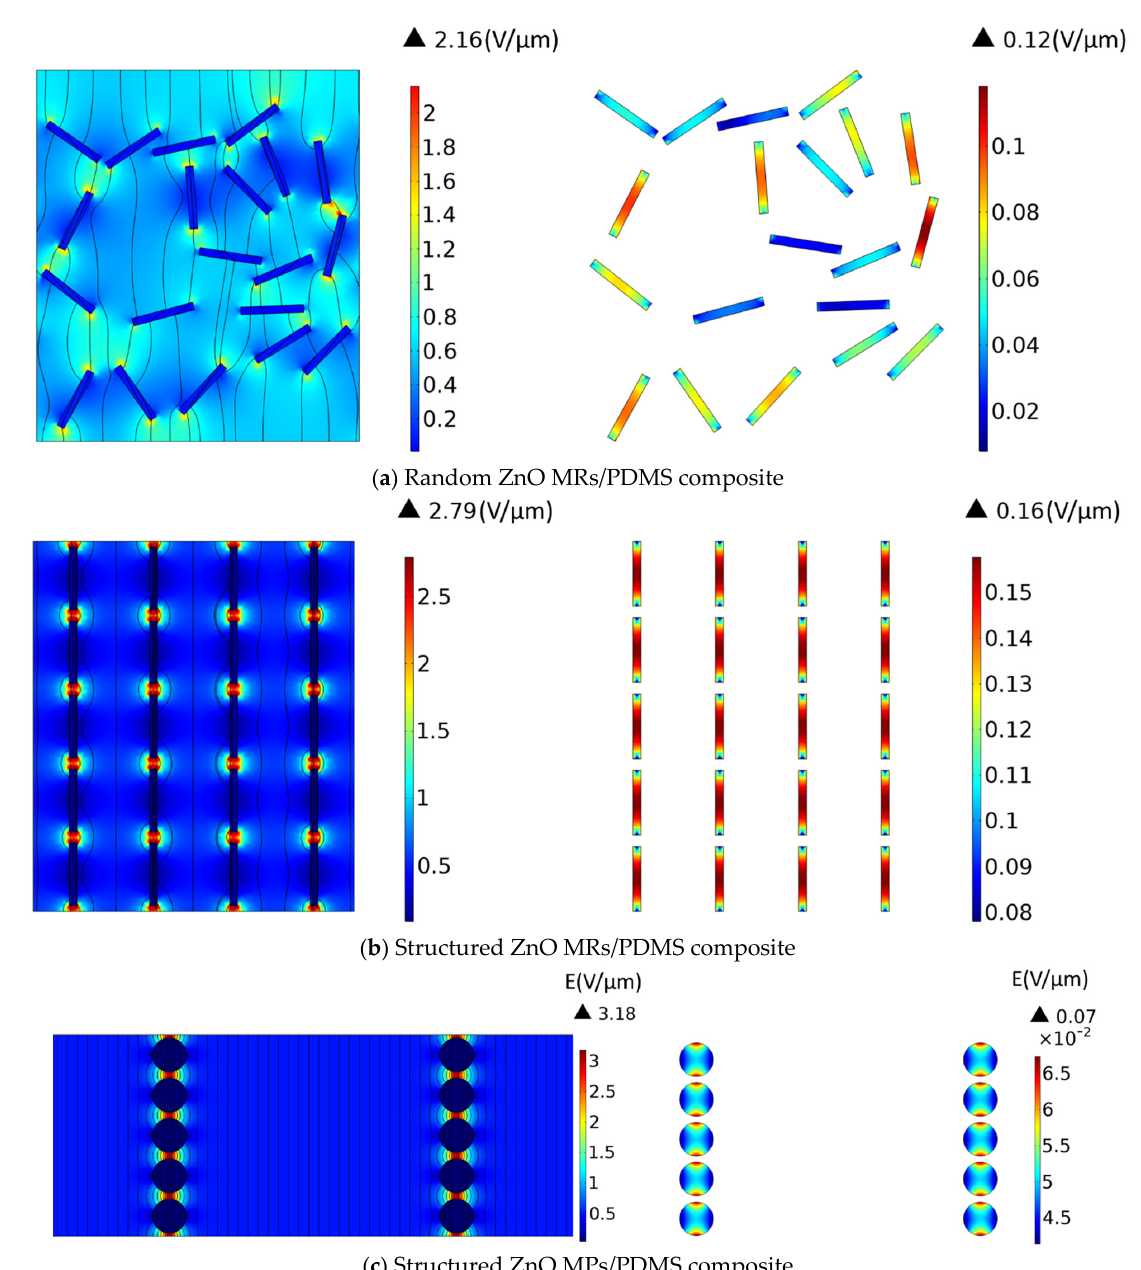
Figure 4. Electric field distribution in the three composites loaded with 8% volume fraction of ZnO fillers, all subjected to the same external excitation of 0.5 V/µm: ( a ) Random ZnO MRs/PDMS; ( b ) Structured MRs ZnO MRs/PDMS; and ( c ) Structured MPs ZnO MRs/PDMS. Two pictures are shown in each subfigure; the one on the left-hand side gives an overview of the whole composite, while the other on the right-hand side provides a closer view of the fillers. Both are not on the same color scale, for an easier visualization.